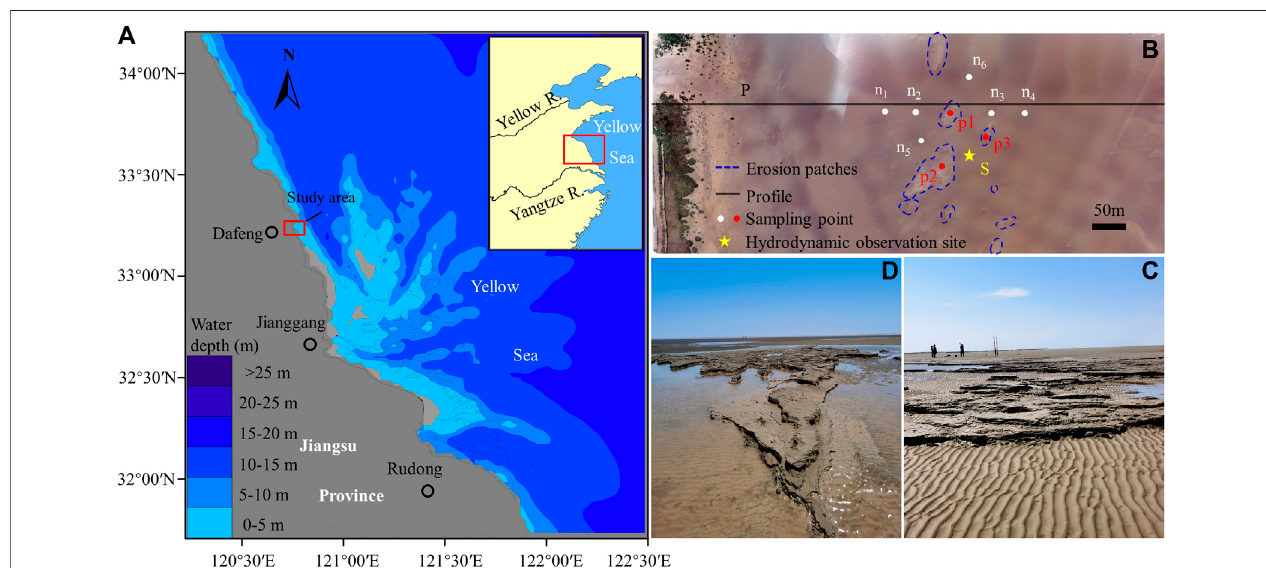
FIGURE2| Locationofthestudyareaandobservationsites(redbox). (A) MapsshowingthestudyarealocatedatDafeng,Jiangsu,China. (B) Topographicmapof the tidal fl at taken by unmanned aerial vehicles, showing hummocky patches (bright color circled by a blue dash line), measuring pro fi le P, sampling points n1 – n6 (white dots on the tidal fl at surfaces), p1 – p3 (red fi lled dots on patches) and hydrodynamic observation site (S). A sediment core with a length of 30 cm was taken at sampling point p1. (C) and (D) show the morphological characteristics of hummocky patches (bright color circled by a blue dash line) distributed in the intertidal